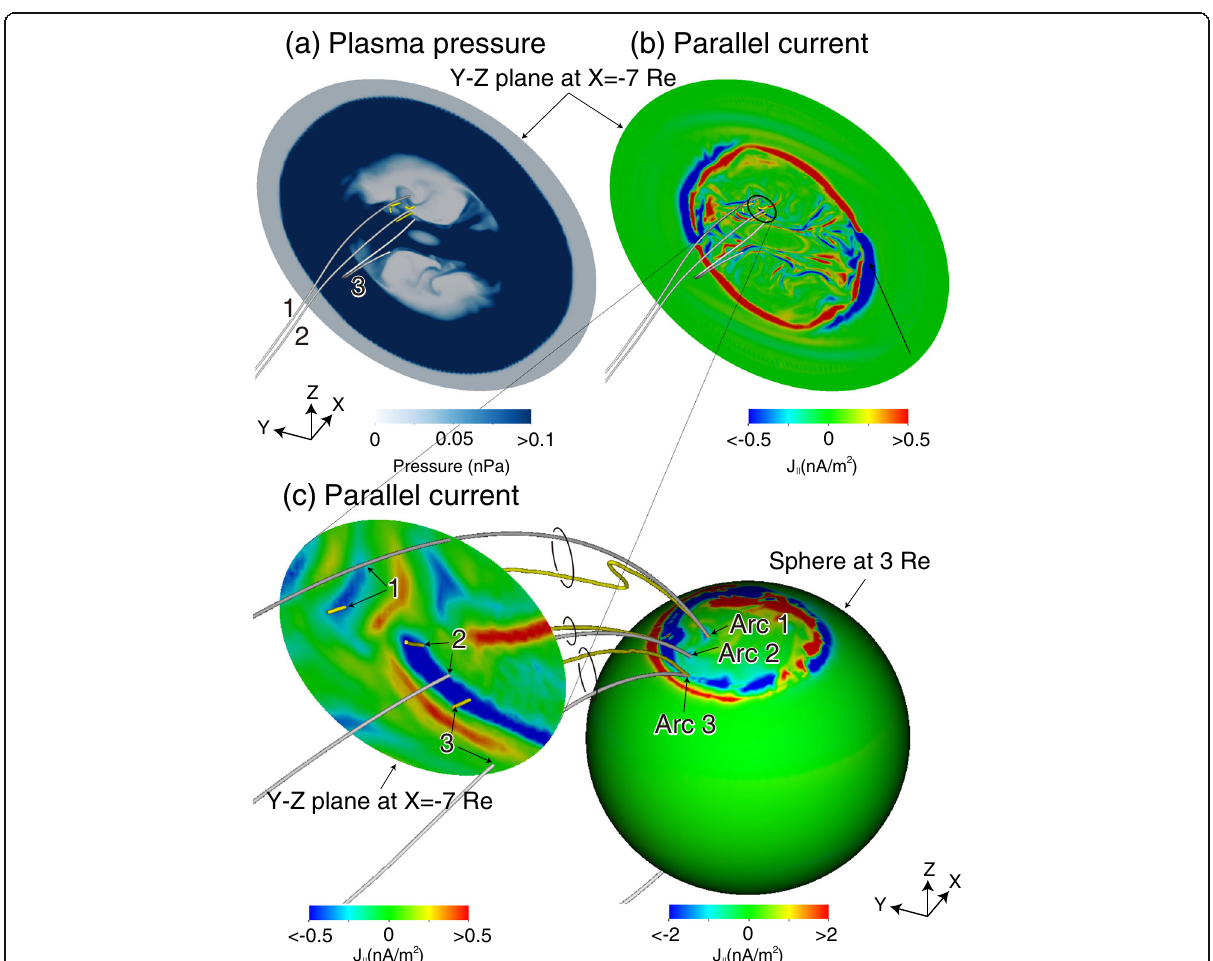
Fig. 8 a Plasma pressure and b , c parallel current density in the Y - Z plane at X = − 7 Re. In c , parallel current is also drawn on the surface at 3 Re. The yellow and white lines indicate the current line and the magnetic field line, respectively, extending from Arcs 1, 2 (high-latitude aurora), and 3 (quiet arc) at T = 43.7 min. The color codes indicate the parallel current density (negative upward in the Northern Hemisphere). (Adapted from Ebihara and Tanaka